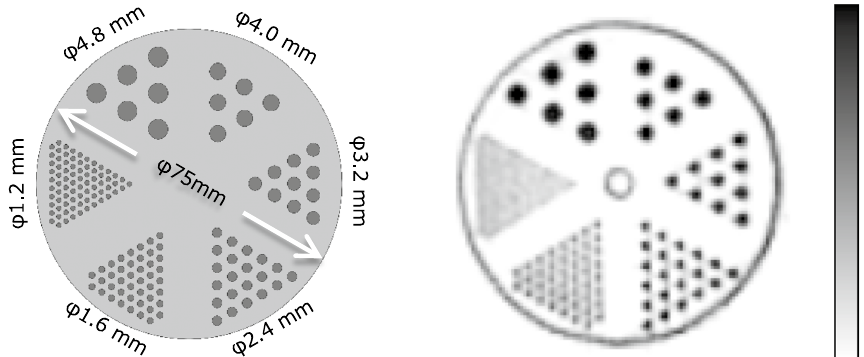
Fig. 7 Image of the mini‑Derenzo phantom. The original distribution (left) and the obtained image (right). Rods of 1.6 mm and higher are visually